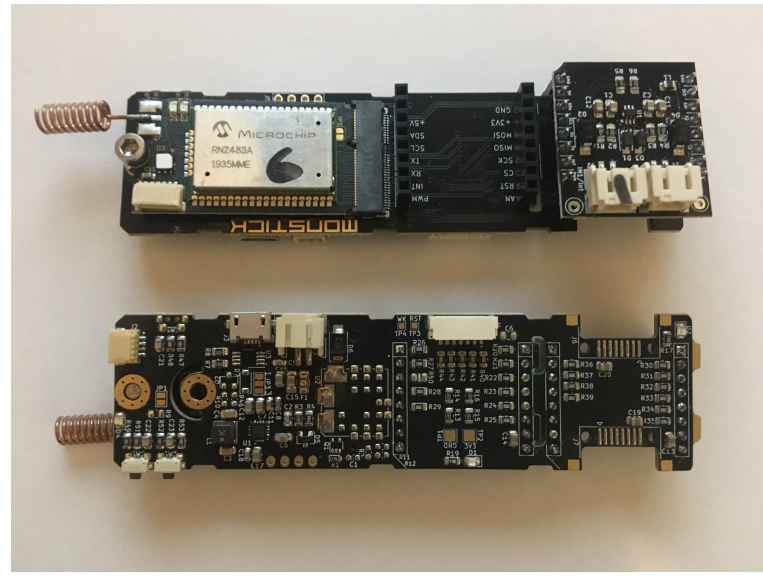
Figure 5. Printed Circuit Board (PCB) with M2.COM module and microBUS module for reading from pulse water